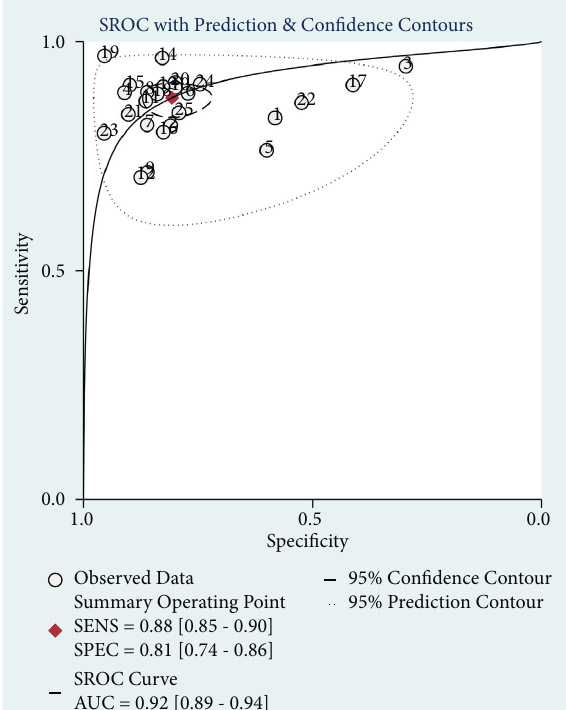
Figure 4: Summary receiver operating characteristic (SROC) curves of AI-aided diagnostic techniques for the diagnosis of